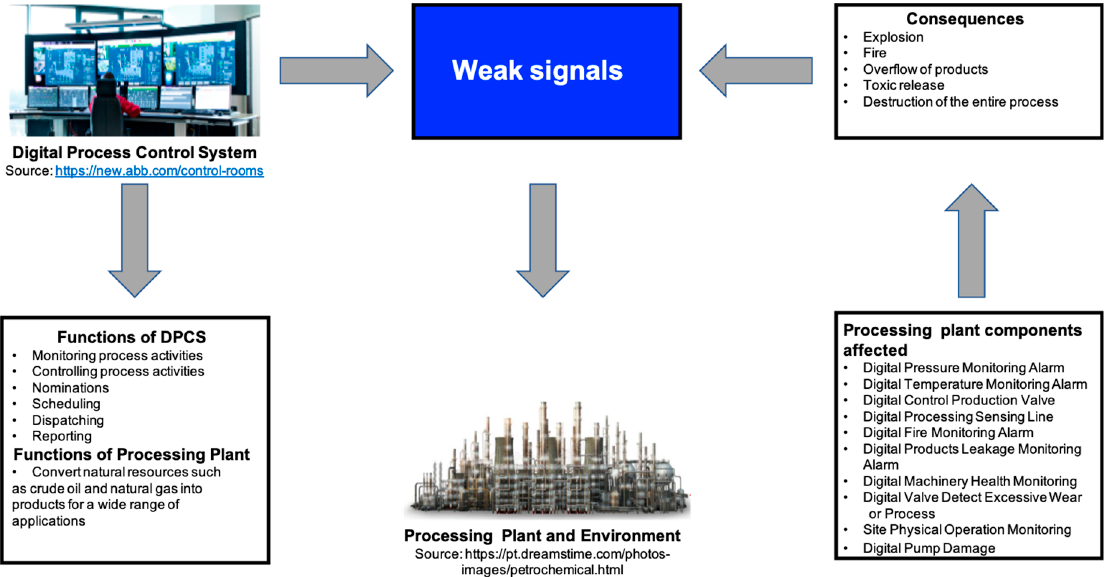
Figure 1. Weak signals and digital process control system.